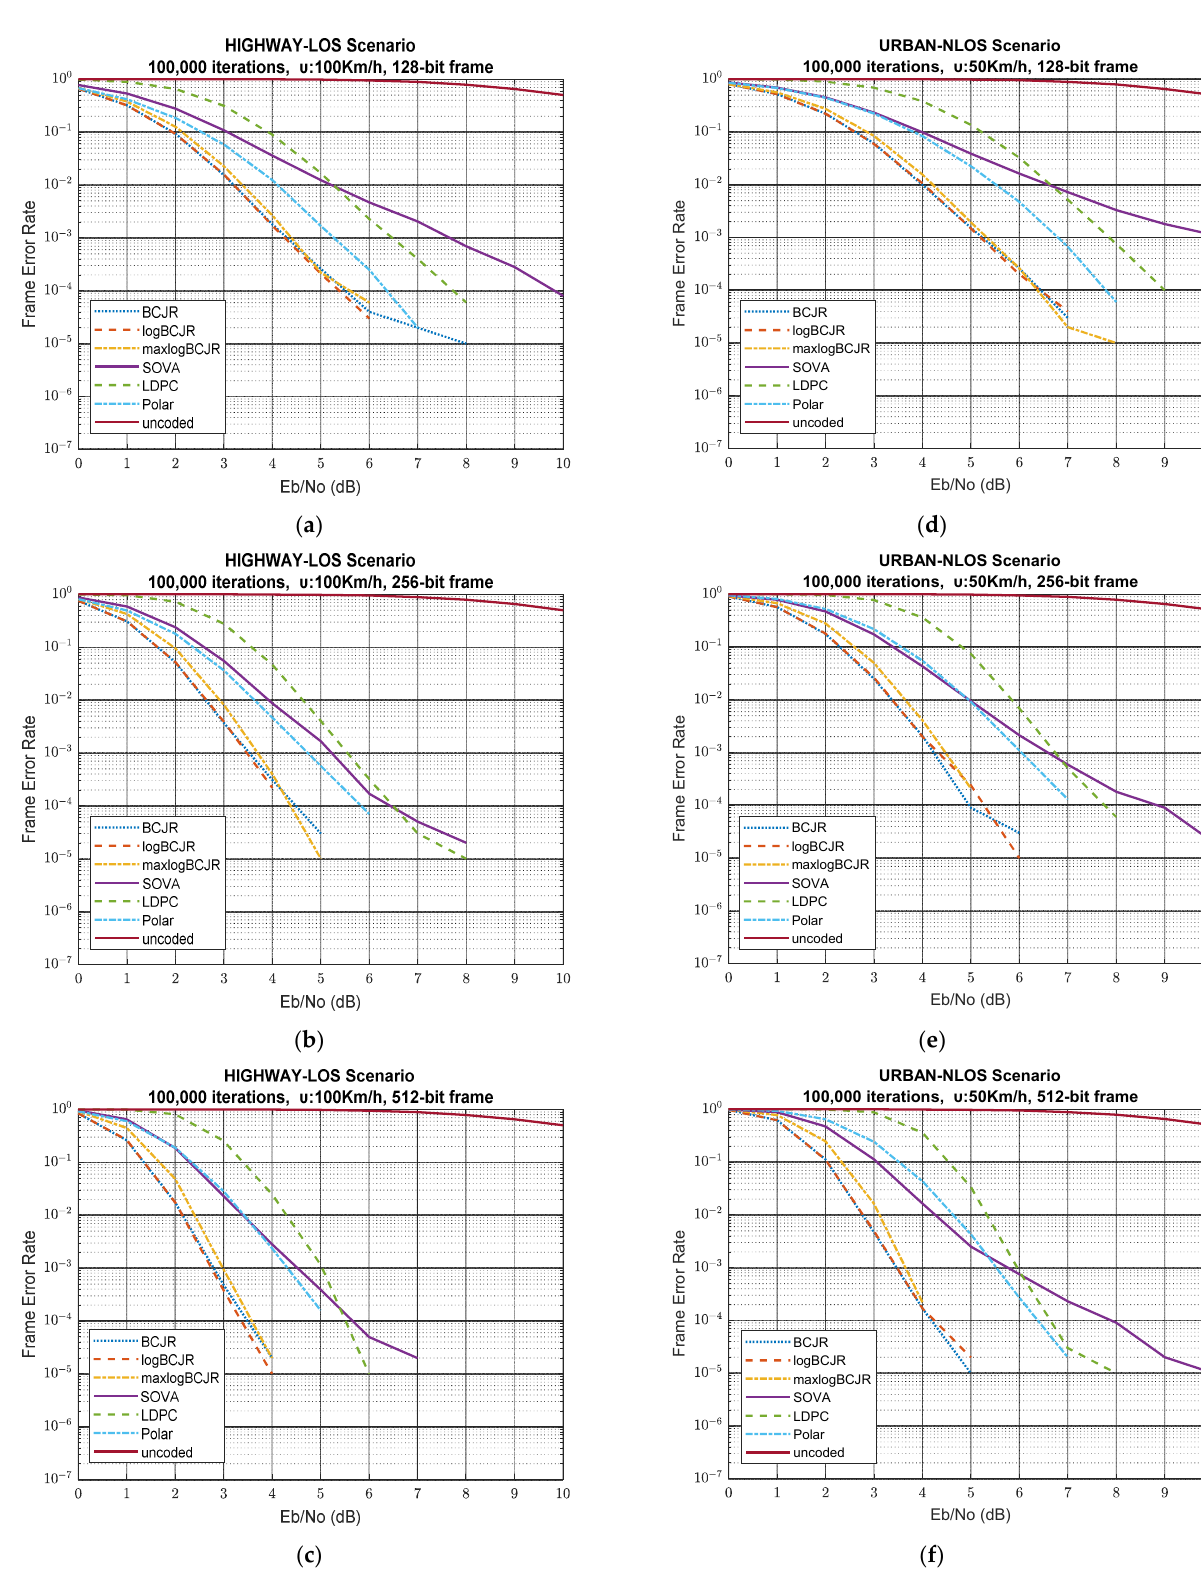
Figure 8. FER vs. SNR . ( a ) highway - LOS scenario 128-bit frames; ( b ) highway - LOS scenario and 256-bit frames; ( c ) highway - LOS scenario and 512-bit frames; ( d ) urban - NLOS scenario and 128-bit frames; ( e ) urban - NLOS scenario and 256-bit frames; ( f ) urban - NLOS scenario and 512-bit frames.